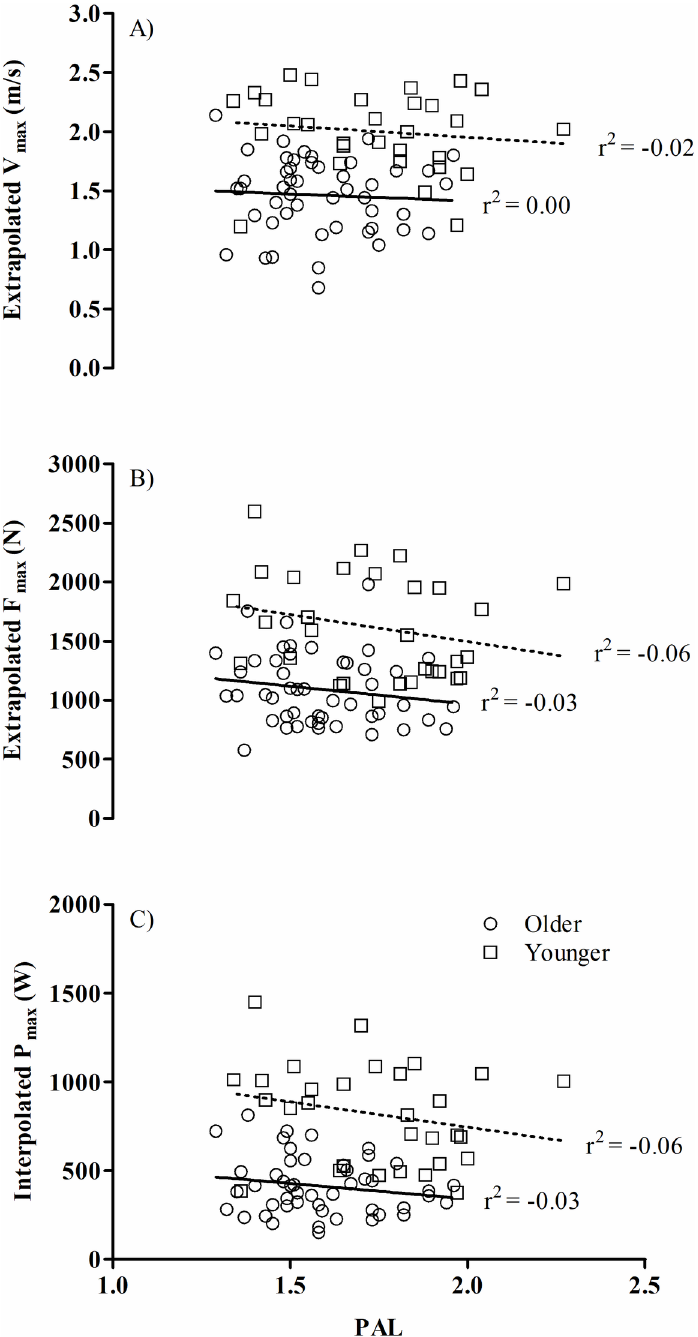
Fig 3. Habitual physical activity level was not associated muscle function in healthy older or younger individuals. Pearson’s correlations between daily physical activity level (PAL) (ratio of total energy expenditure to basal metabolic rate) to A) extrapolated maximum velocity (V max ), B) extrapolated maximum force (F max ), and C) interpolated maximum power (P max ) for 65–80 and 20–35 year olds. The older individuals are represented by circles and the younger individuals by squares. No significant relationships between PAL and muscle function characteristics were identified for either